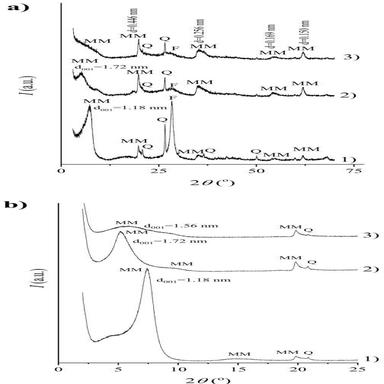
X-ray diffraction patterns of samples a) 3° ≤ 2θ ≤ 70°; b) 2° ≤ 2θ ≤ 25° recorded at higher sensitivity: 1) Na-Wy; 2) AP and 3) CoAP (MM – montmorillonite, Q – quartz and F – feldspar).